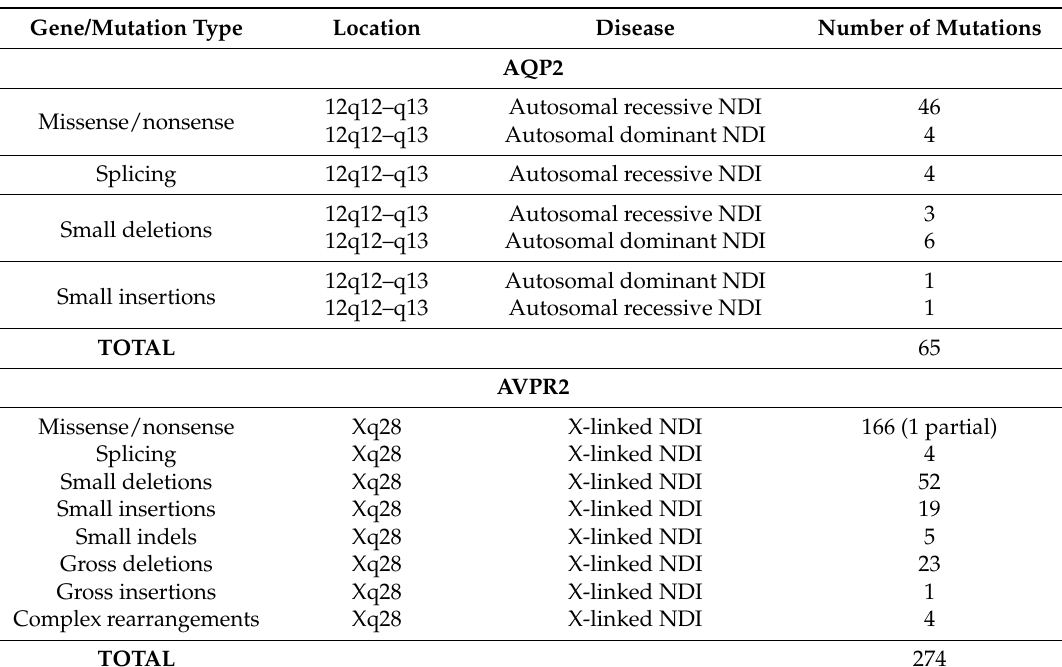
Table 1. Overview and classification of mutations causing nephrogenic diabetes insipidus (NDI) as reported by HGMD ® Professional 2017.3 as of September